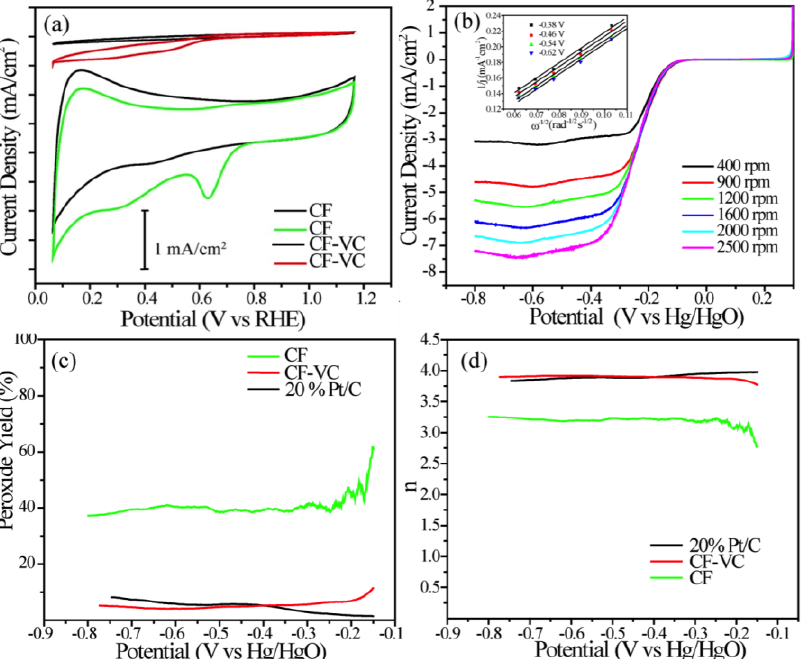
Figure 4. ( a ) Cyclic voltammograms for CF nanoparticles and the CF-VC catalyst in 0.1 M KOH electrolyte at a scan rate of 50 mV/s (nitrogen saturated = black; oxygen saturated = green and red). ( b ) Linear sweep voltamograms (LSV) for the CF-VC catalyst at various rotation rates in oxygen saturated, 0.1 M KOH. A K–L plot from the LSV data is shown as the inset in ( b ). ( c ) Percentage of peroxide formed at various electrode potentials for CF, CF-VC and 20% Pt/C catalyst. ( d ) Number of electrons transferred during the oxygen reduction reaction (ORR) for CF, CF-VC and 20% Pt/C as a function of electrode potential.